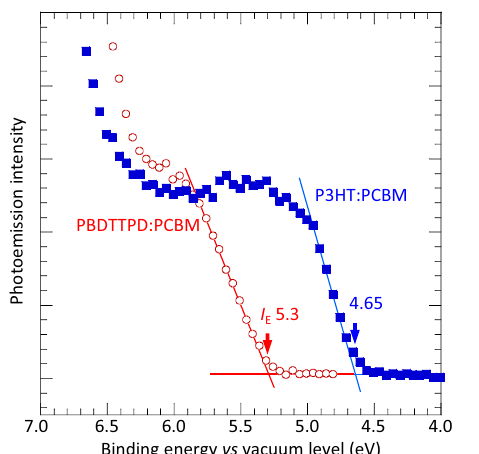
Fig. 2 Ultraviolet photoemission spectroscopy of valence band. Legend: red, PBDTTPD:PCBM (1:1.5 w/w) fi lm; blue, P3HT:PCBM (1:0.8 w/w) fi lm. Ionization energy ( I E ) is marked by standard extrapolation of in fl ection point. Films were measured consecutively in identical con fi guration with same He-I radiation intensity.